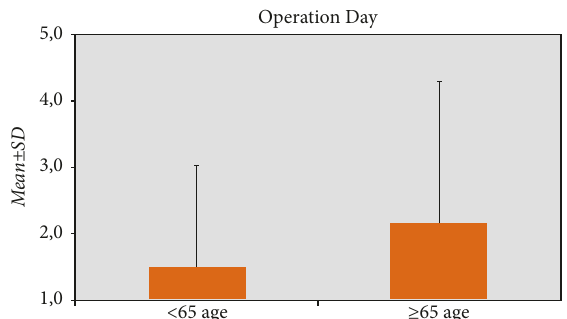
Figure 3: Days scheduled for operation according to